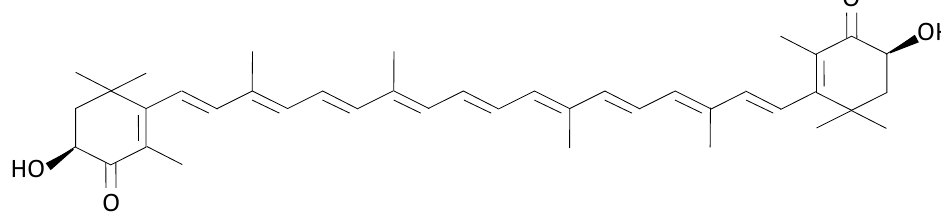
Figure 1. The structure of astaxanthin.